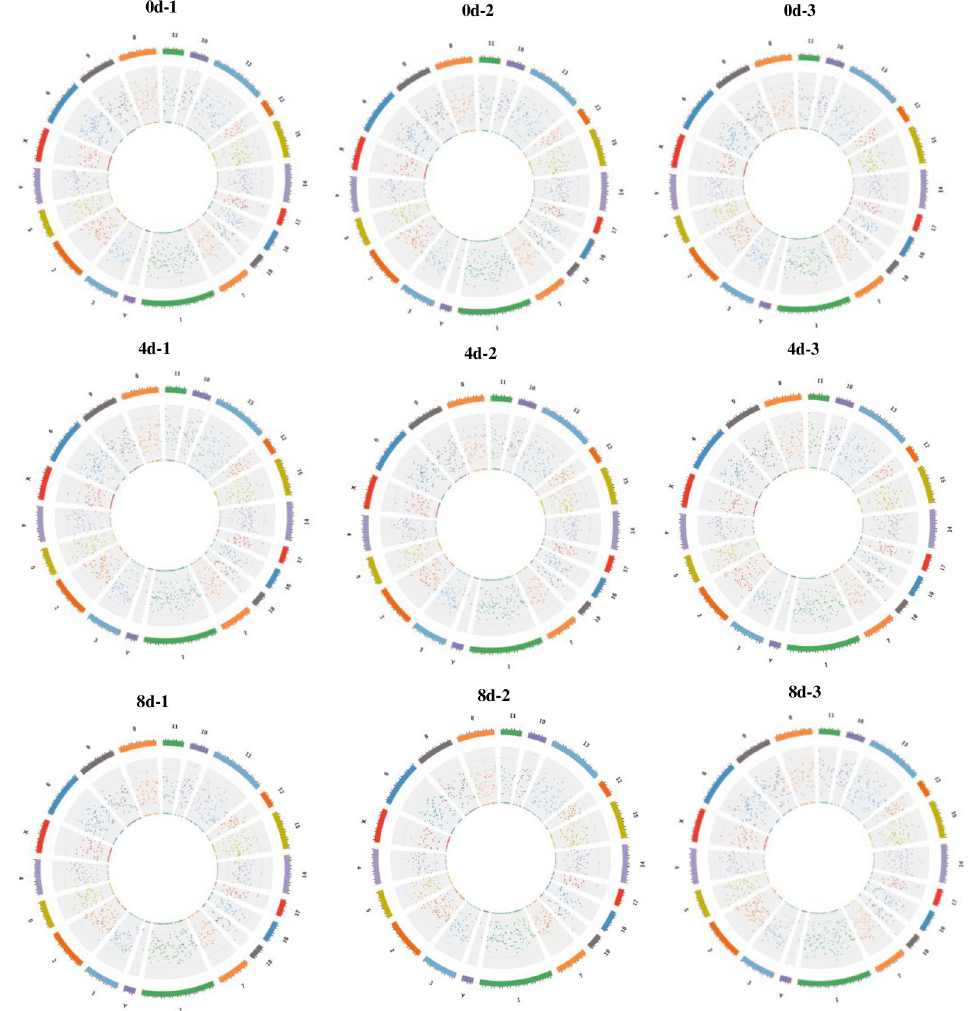
Fig 4. Circos map analysis of circRNA in each